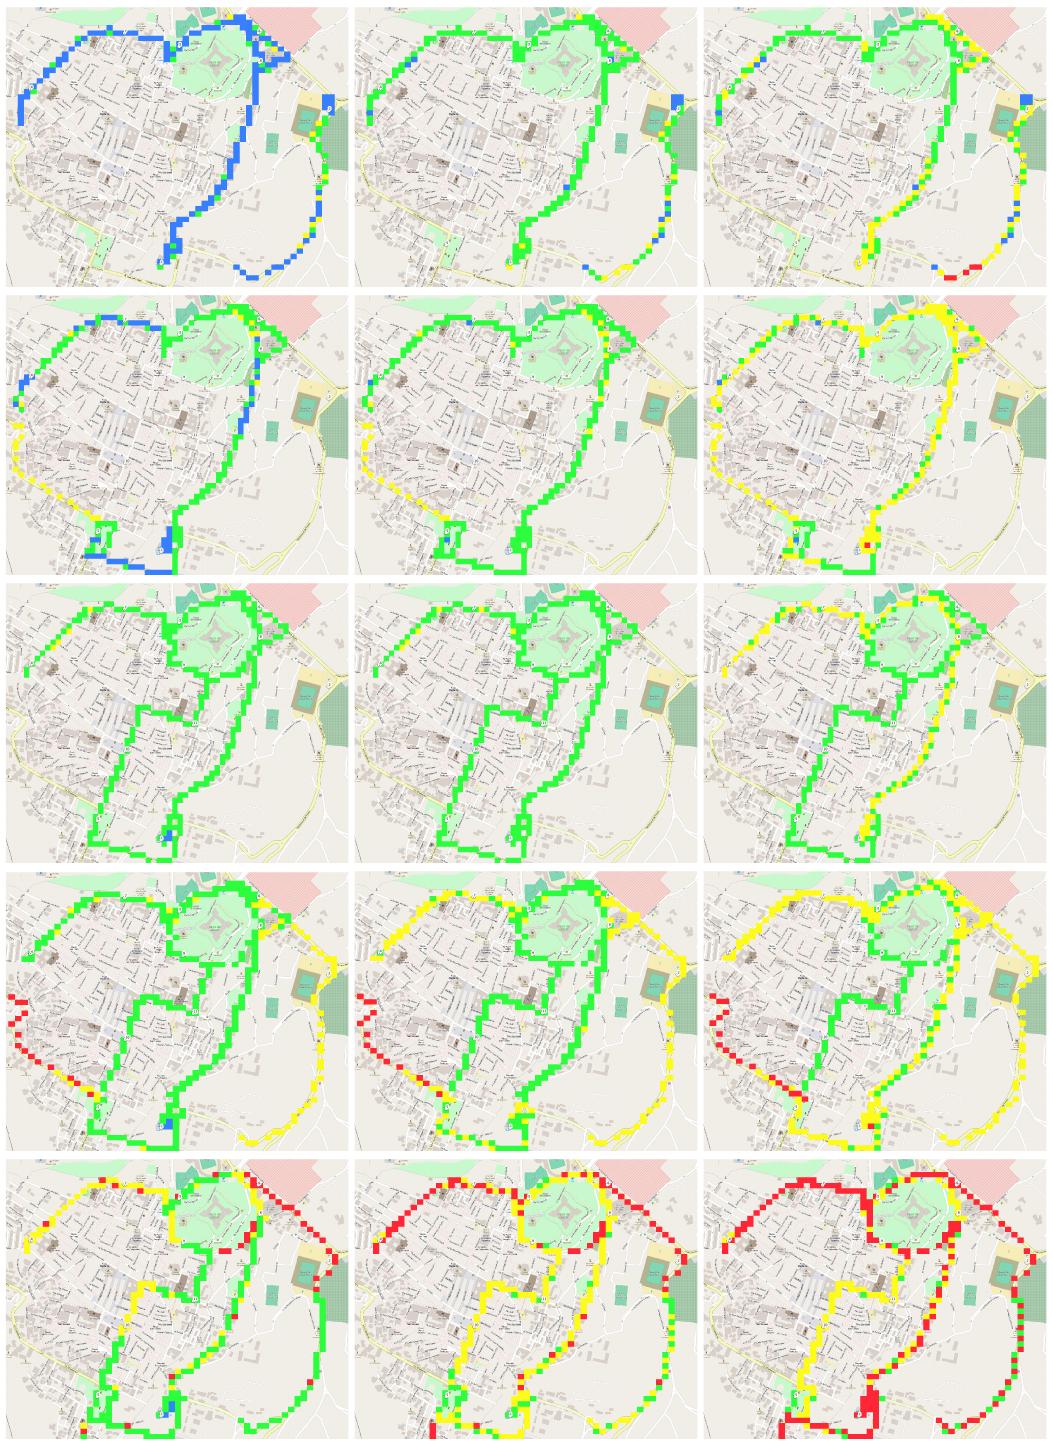
Figure 8. From the top to the bottom, 28–29 August and 1–3 September 2014, maps for AQI hi minimum (left panel), mean (middle panel) and maximum (right panel) values measured during the campaign. Colors are according to Table